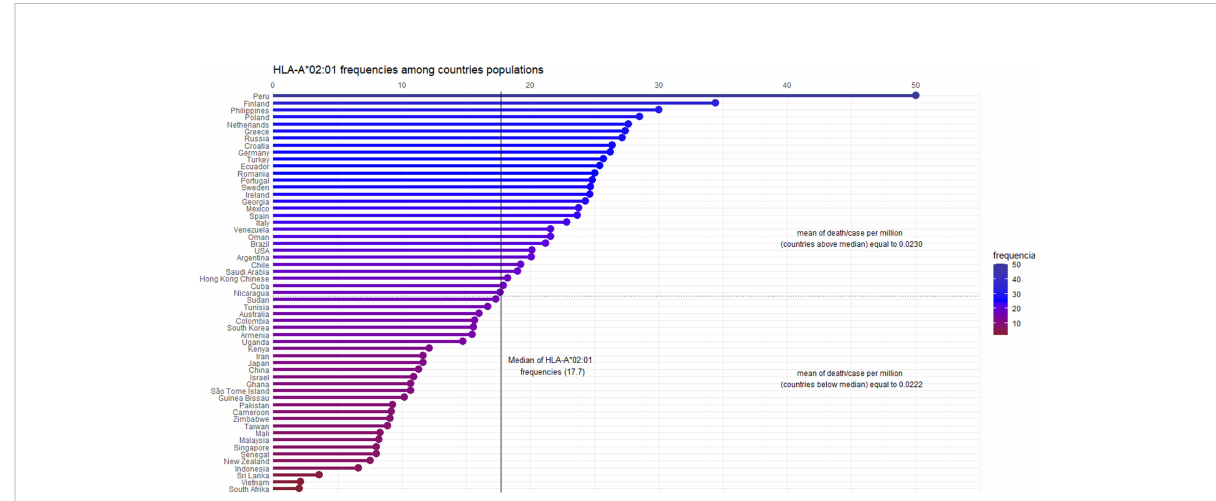
FIGURE 1 Graphical representation of the HLA-A*02:01 allele frequencies, by country. Fifty-seven countries are ordered by their allele frequencies (X-axis) from the highest to the lowest. The frequency values were calculated based on Alleles Frequency Net Database, fi ltering for gold and silver standard samples. Considering more than one population per country, we estimated the weighted average to represent countries ’ frequency. The median of HLA-A*02:01 frequency among the 57 countries is 17.7. Ninety- fi ve percent of the countries have frequency values above 5%, showing the high allele prevalence among the human populations. The death/case per million average shows no statistical difference (con fi dence intervals of 95 and 99 percent) among countries above and below the median (p - value =